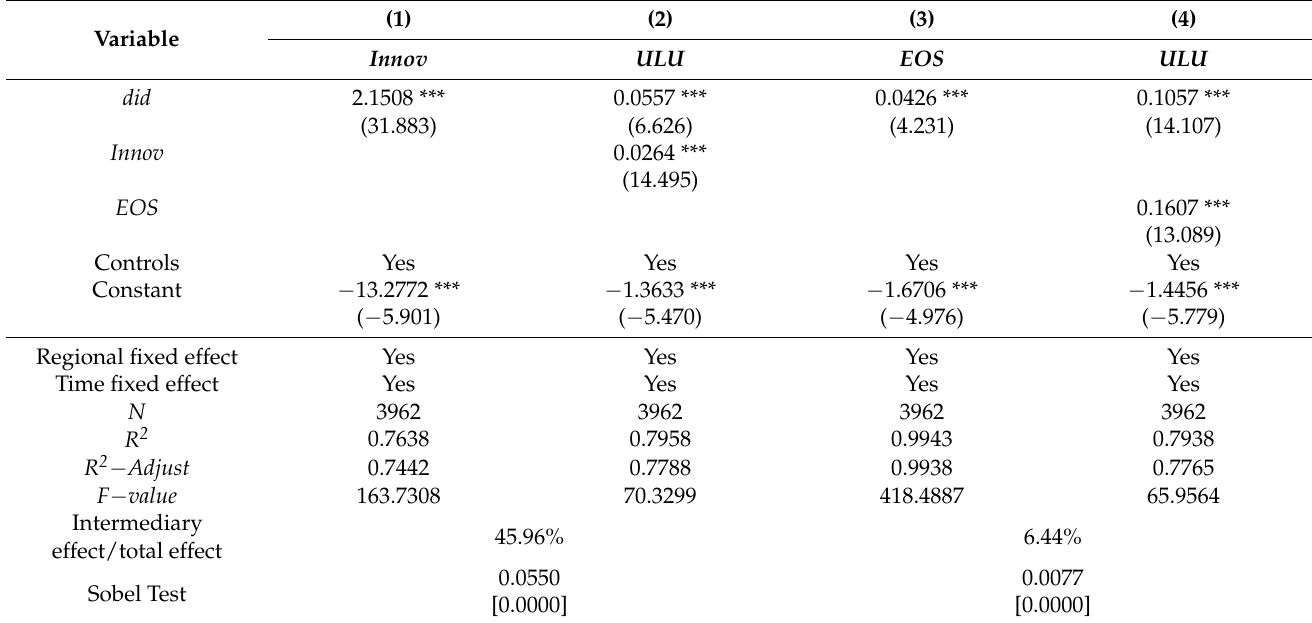
Figure 4. Placebo test. Table 7. Mechanism